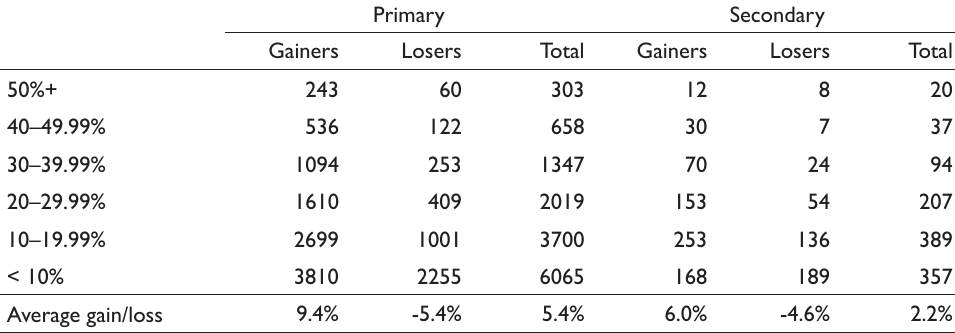
Table 2: Numbers of schools gaining and losing grant income by FSM band and average gain/loss, 2009/10 to 2013/14 Primary Secondary Gainers Losers Total Gainers Losers Total 50%+ 243 60 303 12 8 20 40–49.99% 536 122 658 37 1610 409 2019 153 207 2699 1001 3700 253 136 389 < 10% 3810 2255 6065 357